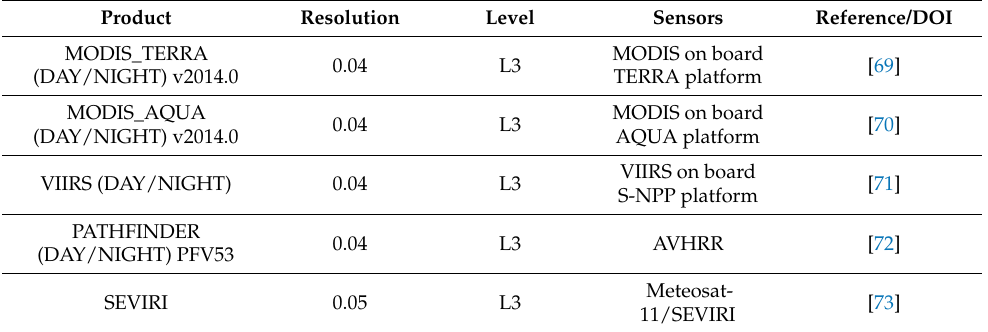
Table 2. Description of the various Level 3 (L3) SST products used in this study, including only high-resolution SST